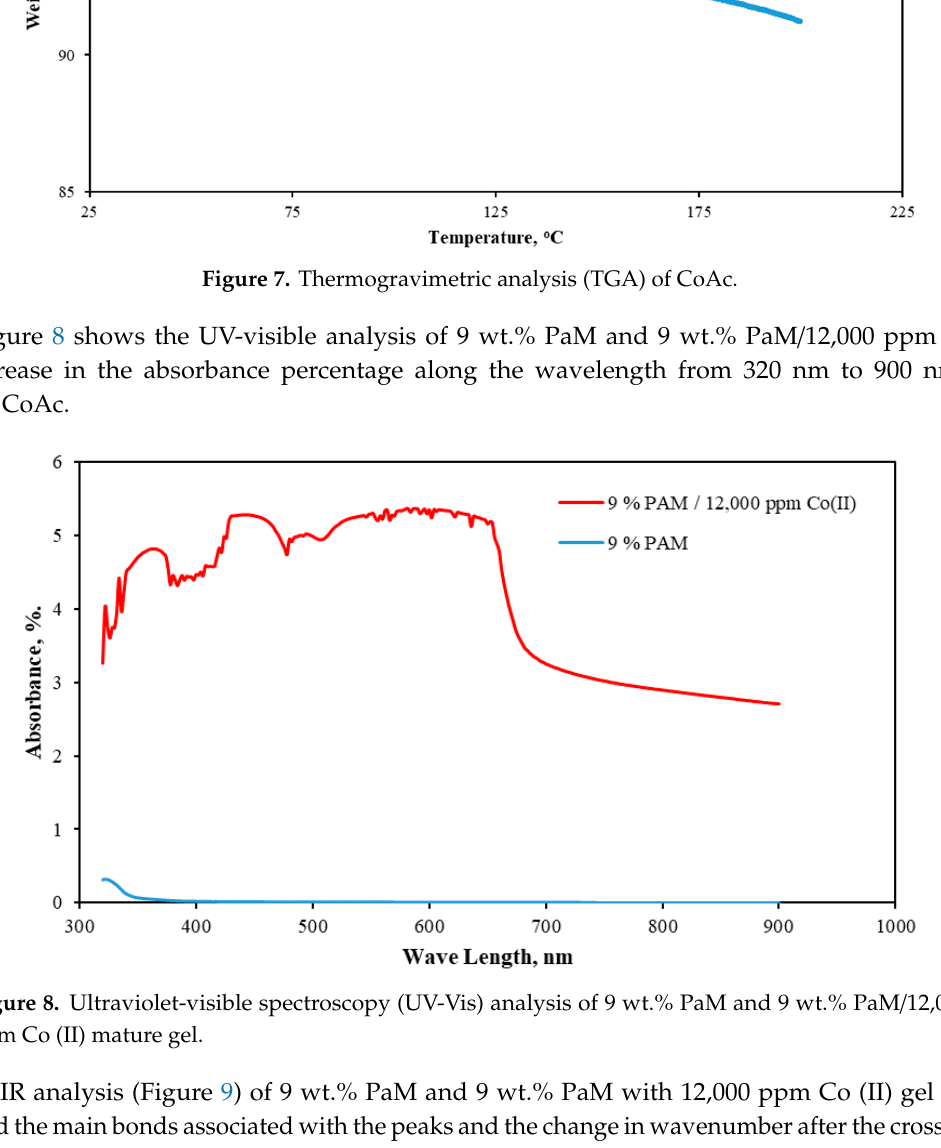
Figure 6. Physical appearance of gel : ( a ) Gels formed after crosslinking 9% PAM/12,000 ppm Co (II)